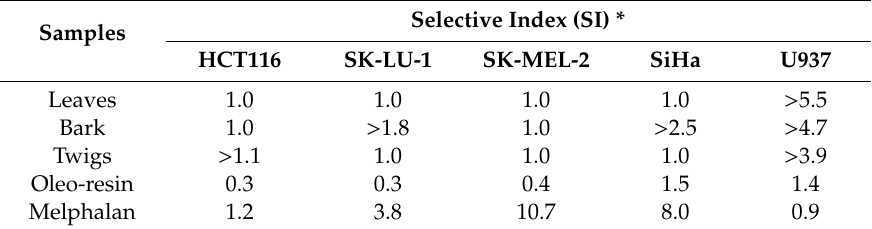
Table 4. Selective index of D. alatus leaf, bark and twig extracts, and oleo-resin.